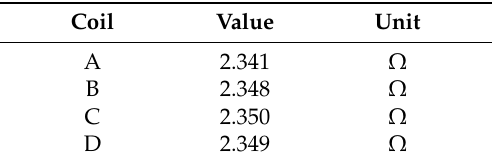
Table 2. The resistance test results for the four square coils.